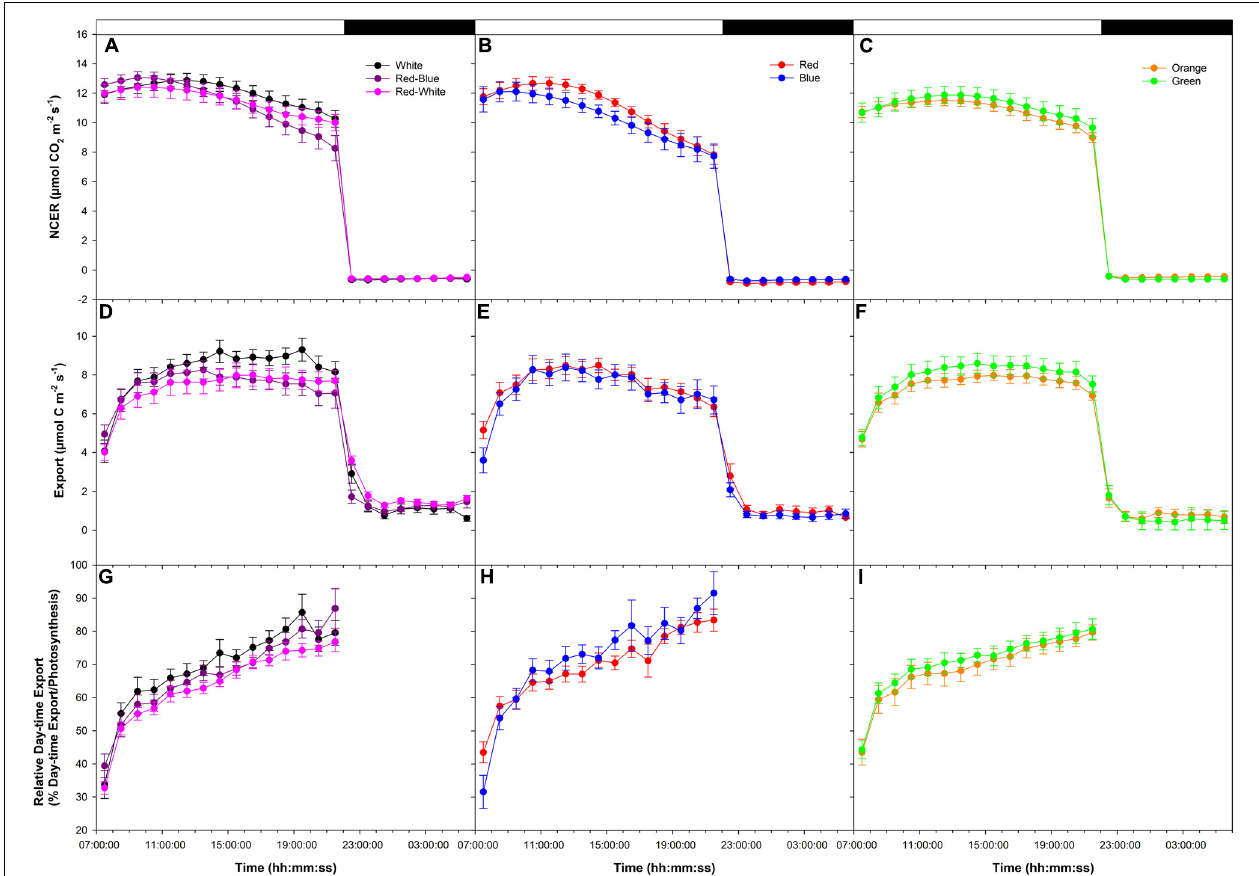
FIGURE 1 | Daily patterns of leaf net carbon exchange rate (NCER) and export at an initial high photosynthetic rate of ∼ 12 µ mol m − 2 s − 1 as affected by different spectral qualities. The NCER (A–C) , export (D–F) , and relative export (export as a percentage of photosynthesis; G–I ) exposed to mixed light-emitting diodes (LEDs), red-blue (RB), white (W), and red-white (RW) are shown in A,D,G . The NCER, export, and relative export from R and B are shown in B,E,H while O and G are shown in C,F,I respectively.